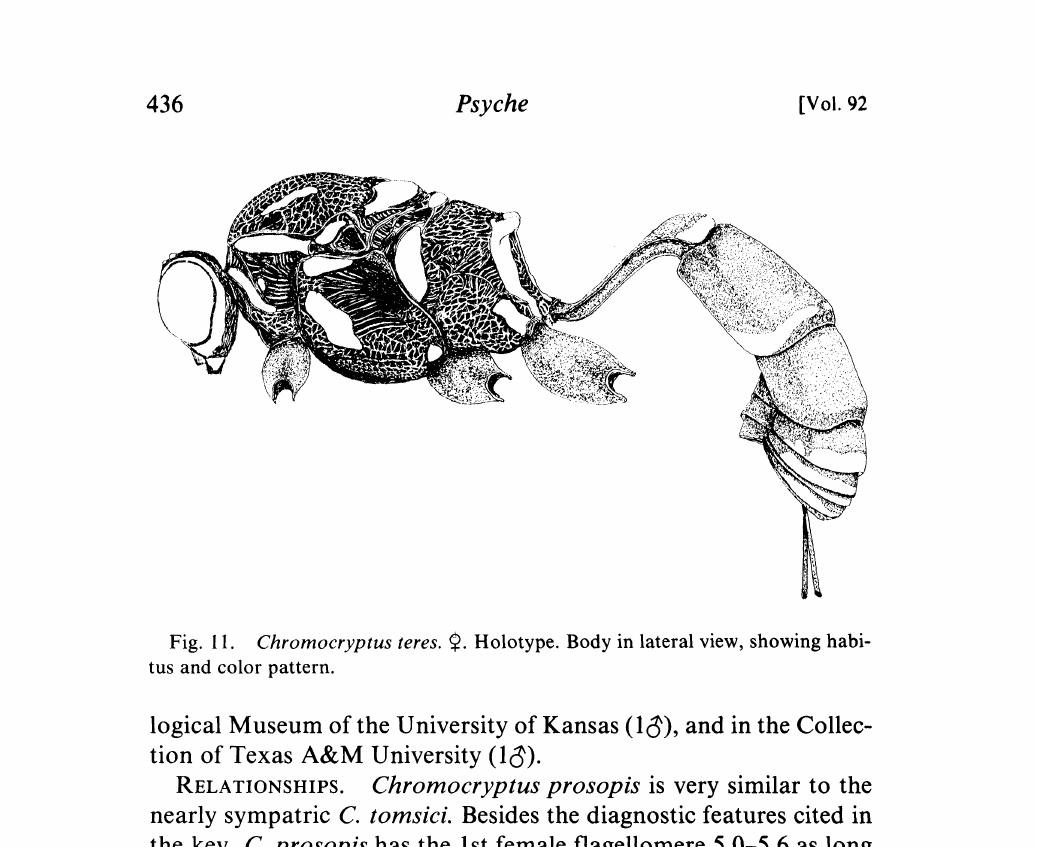
Fig. l. Chromocryptus teres. tus and color